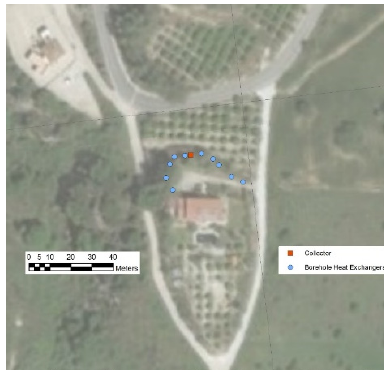
Figure 5. BHE locations.